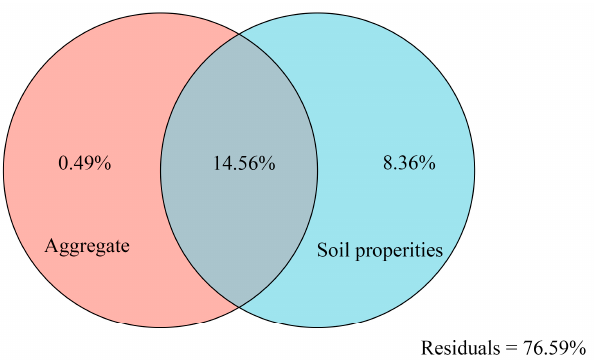
Figure 8. Variation-partitioning analysis (VPA) of the bacterial communities explained by the soil aggregates and soil properties following afforestation.